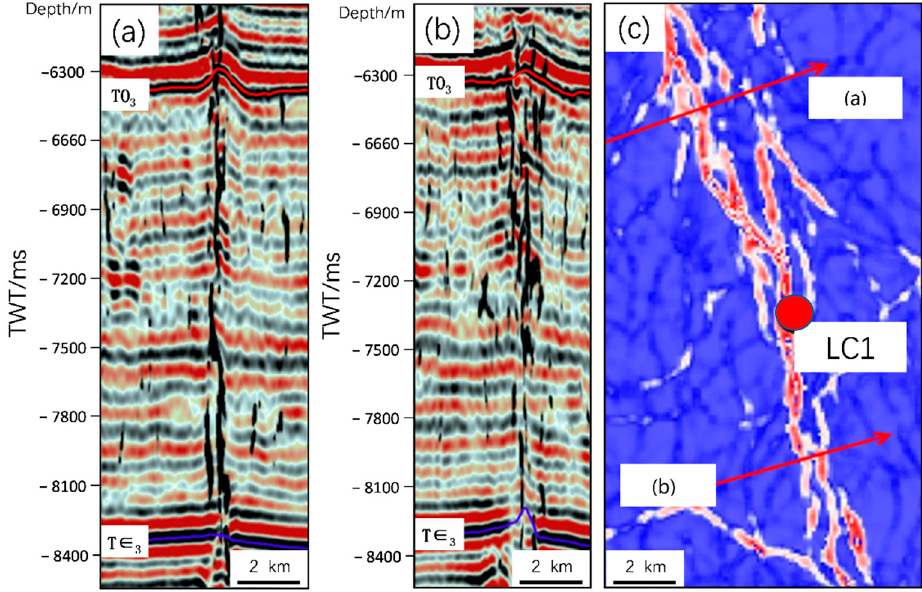
Figure 3. Typical seismic section ( a , b ) and plane attribute ( c ) processed by maximum likelihood in the Fuman Oilfield. the Fuman